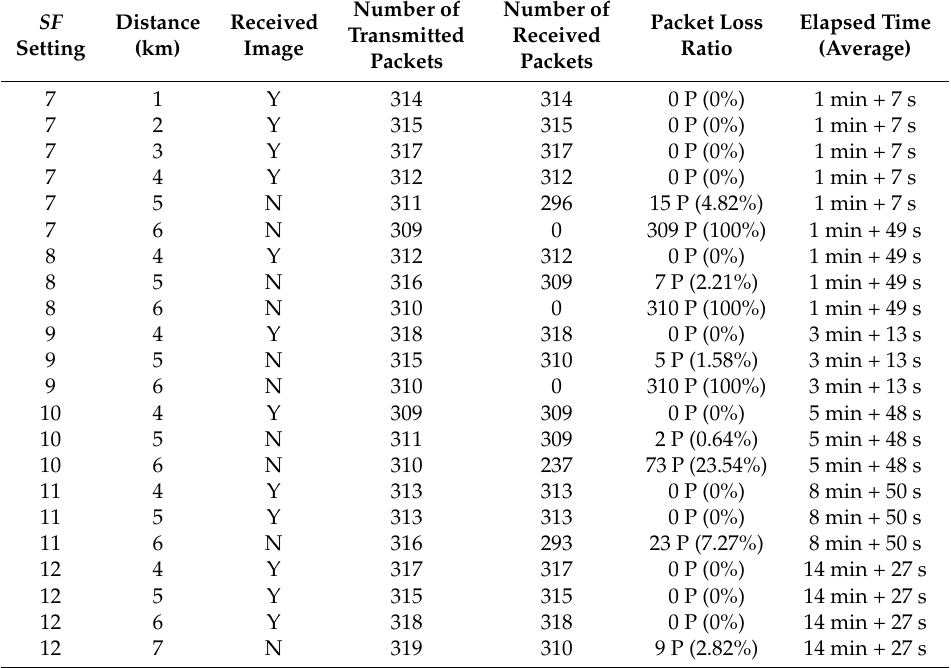
Table 3. Packet loss